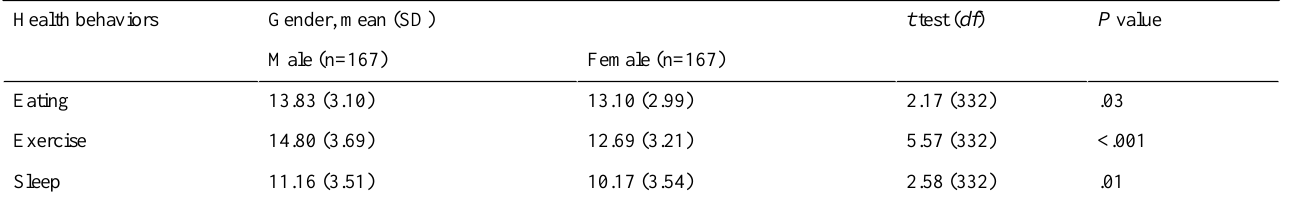
Table 2. Health behavior scores showing gender